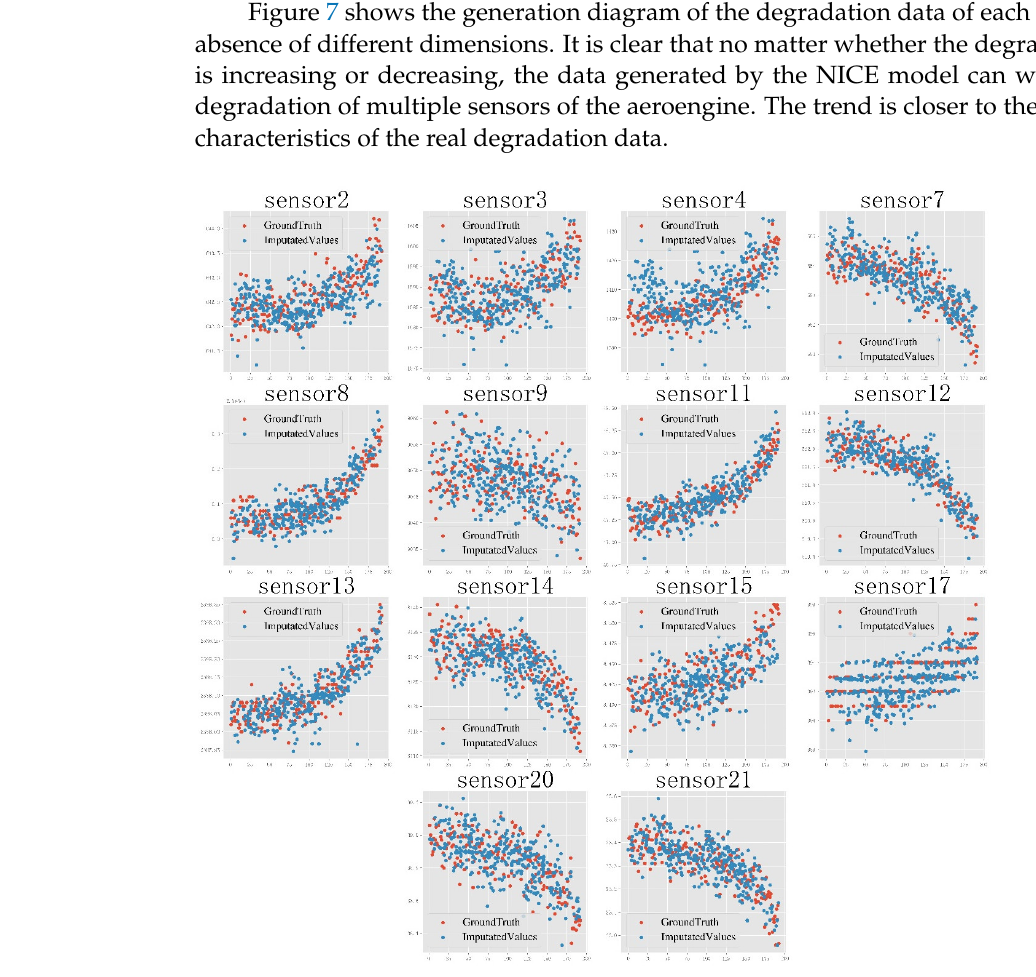
Figure 7. Degradation data generation diagram of 14 sensors of the aeroengine.